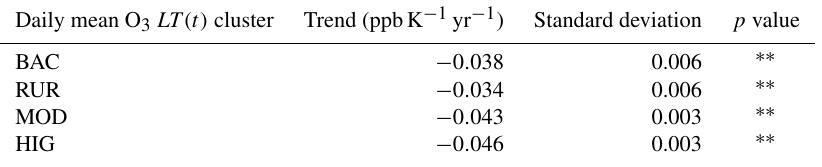
Table 4. Linear trends of the O 3 –temperature slope (based on daily maximum values) for the daily mean O 3 LT (t) clusters for the time period 2000–2015: ∗∗ indicates a highly significant trend ( p value < 0.01), and – indicates a nonsignificant trend ( p value >